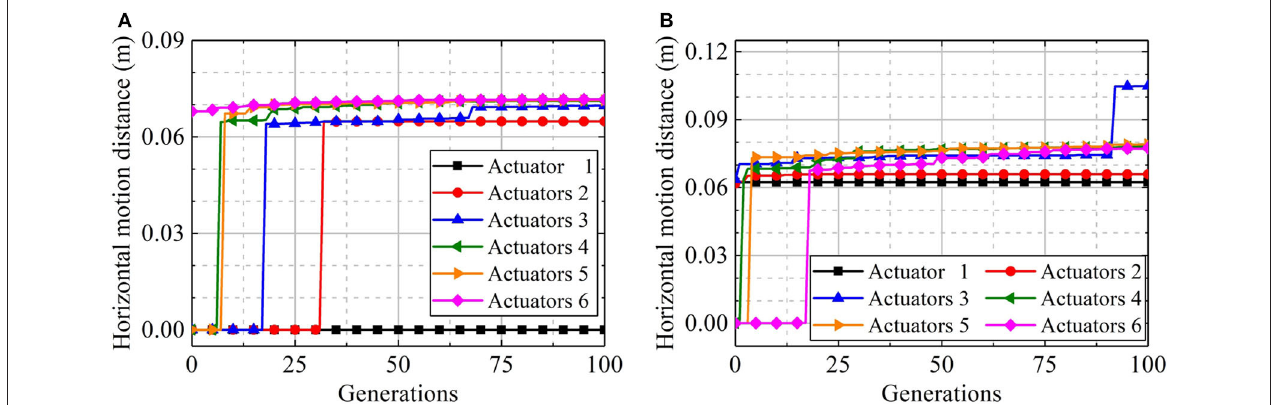
FIGURE 8 | Motion distance vs. generations: (A) TC state and (B) TO state.